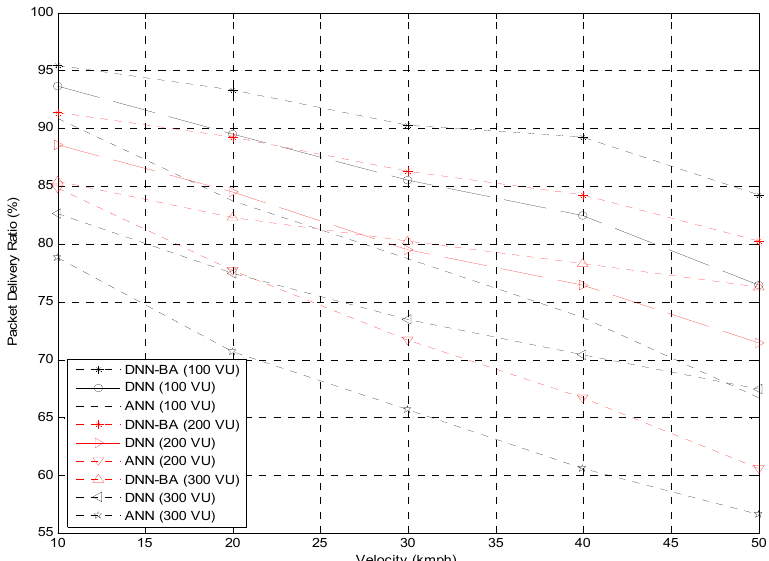
Figure 7. Impacts on packet delivery rate with variable velocity.